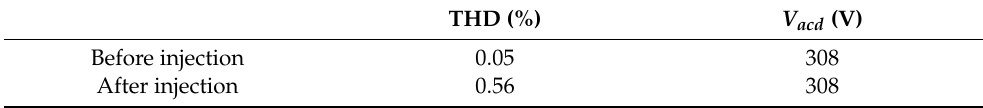
Figure 6. Injected signal. Table 3. FFT analysis of the impact of the injection.